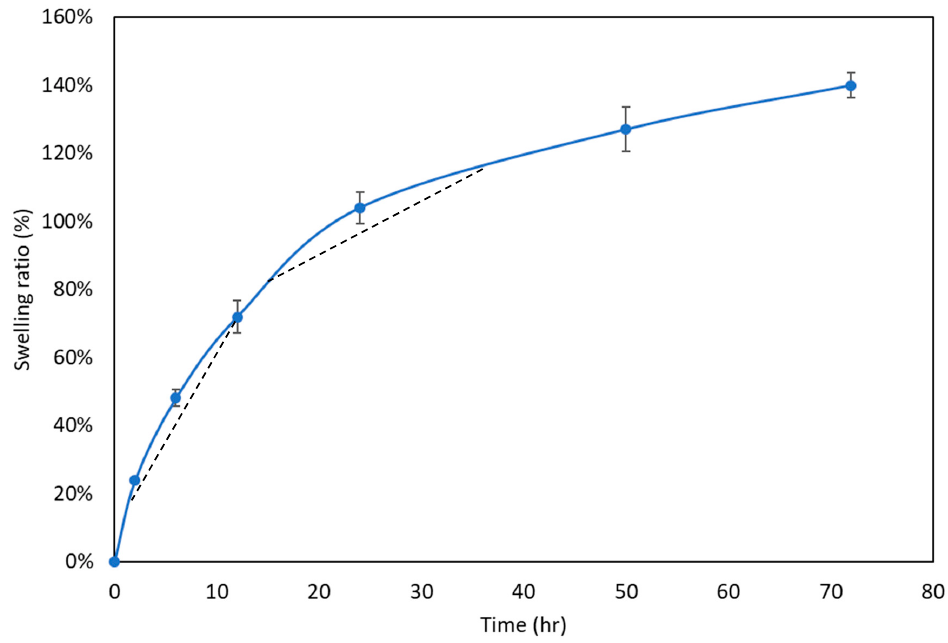
Figure 3. Swelling ratio test ( n = 6). The Gel-HA/CS/HAP composite performed two-stage swelling. The first stage was the result of hyaluronic acid, and the second stage was caused by gelatin.